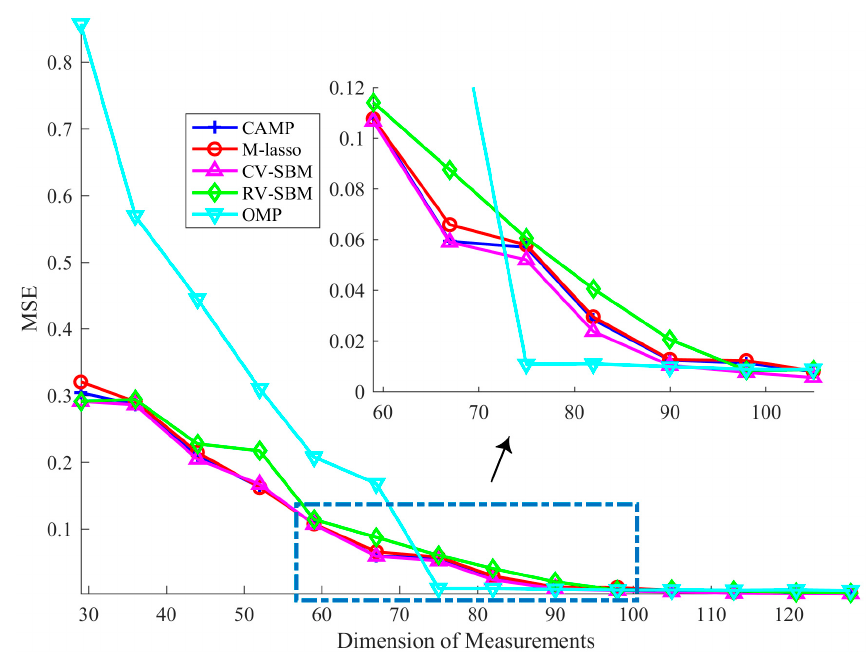
Figure 4. Average MSE in different measurements dimensions.